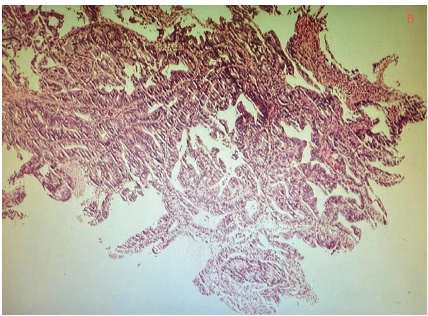
Figure 3: H&E slide: fragments of a tubular adenoma with high- grade dysplasia (intramucosal